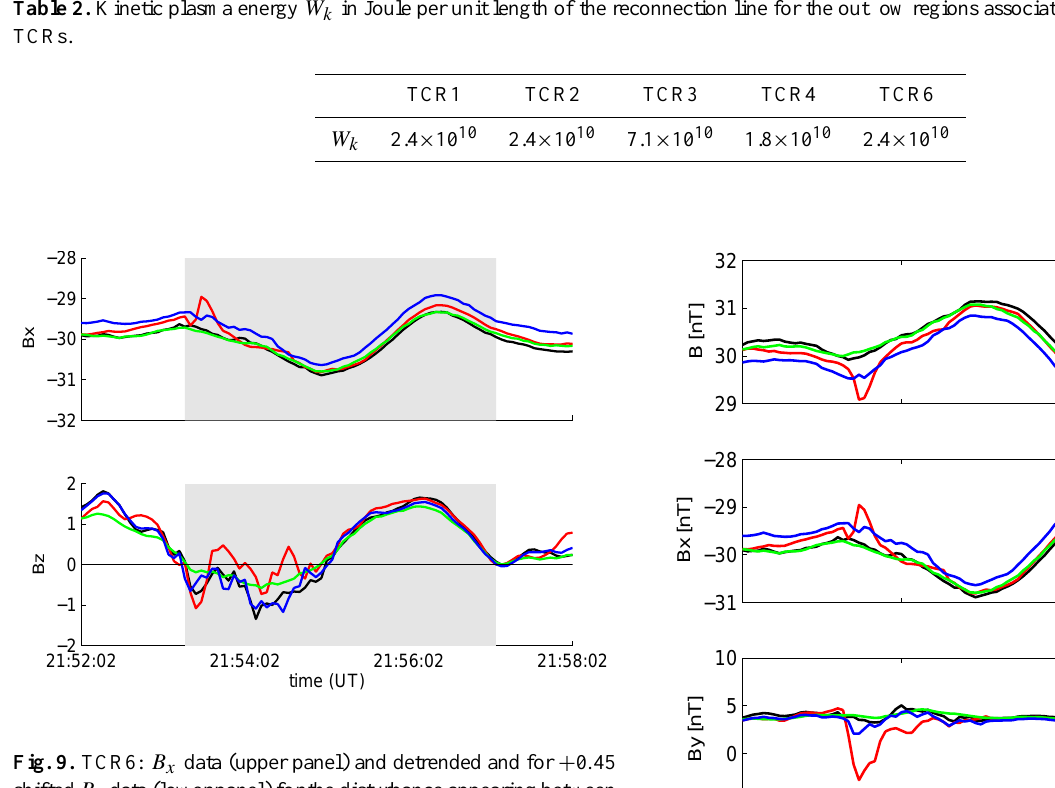
Fig. 9. TCR6: B x data (upper panel) and detrended and for + 0 . 45 shifted B z data (lower panel) for the disturbance appearing between 21:53:06 and 21:56:54UT.